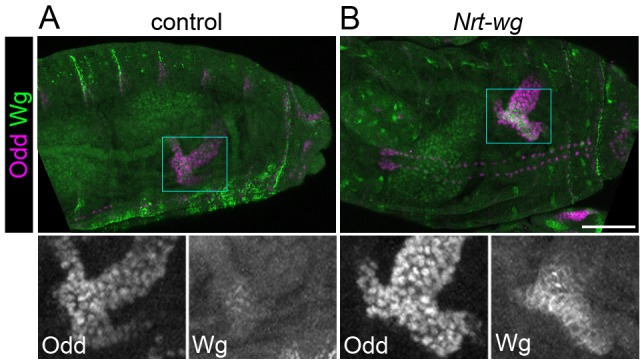
Expression of Nrt-wg.Maximum intensity projections of approximately stage 16 Drosophila embryos, oriented anterior left, stained with anti-Odd and anti-Wg. Bottom panels show enlargement of areas marked with squares. (A) Control (w1118) embryo. (B) Embryo expressing Nrt-wg in homozygous wg mutant background (Nrt-wg). Images were taken using identical microscope settings. Scale bar = 50 μm.10.7554/eLife.35373.009Figure 4—figure supplement 2—source data 1.Quantifications of Odd skipped domain length upon overexpression of Wg or Nrt-Wg.